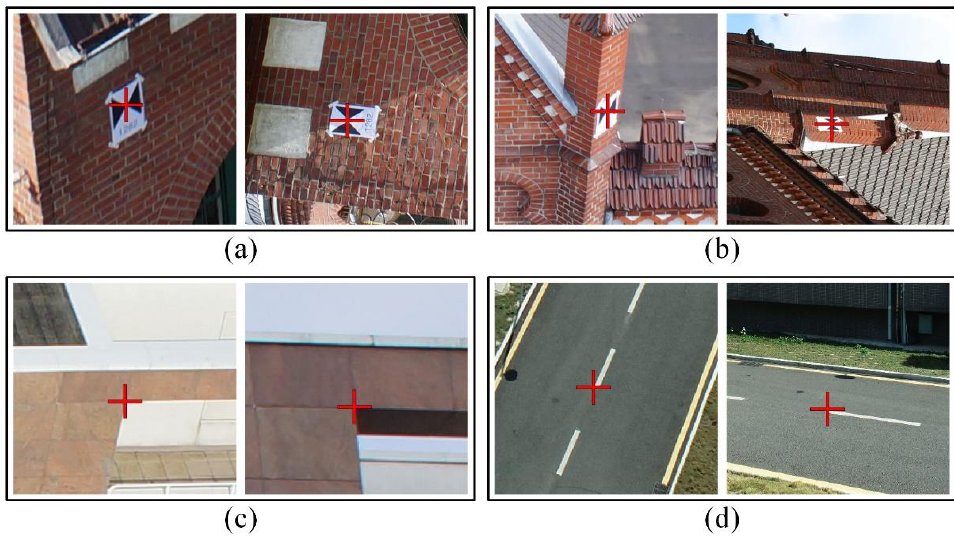
Figure 4. Samples of checkpoints measured in the tested datasets. In each subgraph, the left is measured in aerial (UAV) image while the right is measured in terrestrial image. ( a , b ), checkpoints measured on targets; ( c , d ), checkpoints measured on distinct corners.